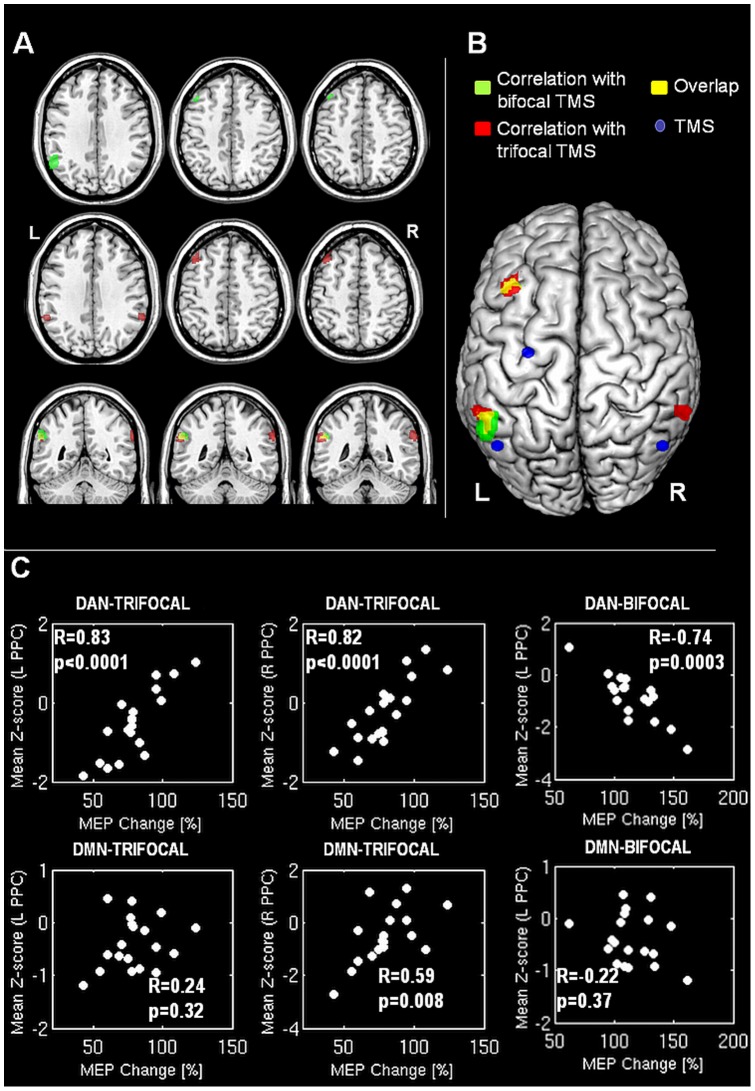
correlation between TMS and fMRI data.In panel A and B, areas of correlation between the dorsal attention network (DAN) and bifocal TMS are shown in green, while correlations between the DAN and trifocal TMS are shown in red. Overlapping regions are in yellow. Panel B also shows the sites of TMS stimulation (blue dots). The scatterplots reported in the upper row of panel C show the mean cluster Z-score (indicating the strength of functional connectivity estimated by resting state fMRI) against the percentage change in MEP for the 3 highlighted regions. In the lower raw of panel C, the corresponding mean Z-score relative to the default mode network (DMN) are also plotted against the percentage change in MEP (bottom row), but correlations were not significant. The directions of correlation (direct or inverse) are reversed in the two cases (bifocal and trifocal TMS) as expected due to the opposite (excitatory or inhibitory) nature of the underling connections. R and p values are estimated post-hoc using Pearson's correlation coefficient. See text for further details.